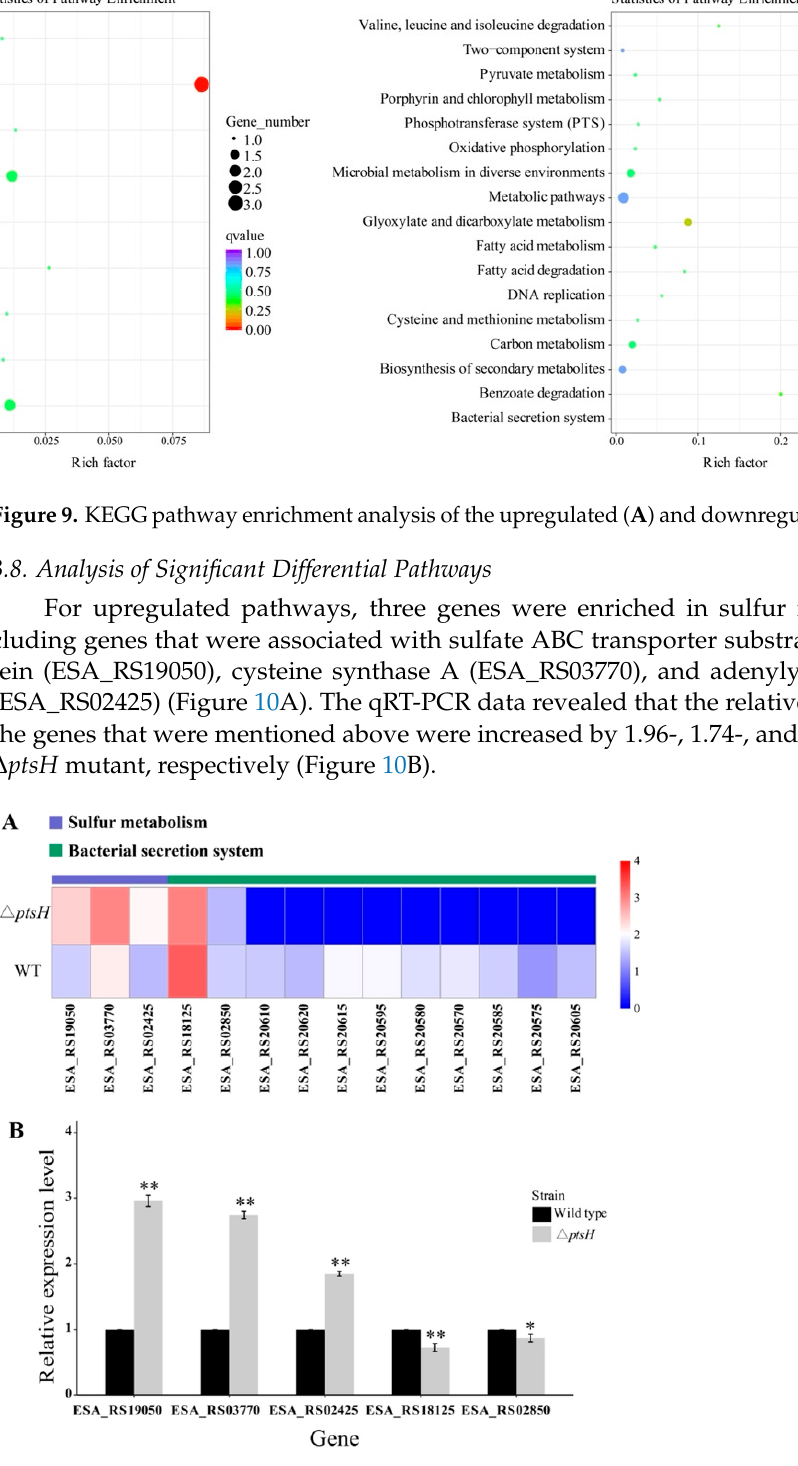
10 of 17 Figure 8. Volcano map of differentially expressed genes between the WT strain and the Δ ptsH mu- tant. Red dots represent the upregulated genes, green dots represent the downregulated genes, and